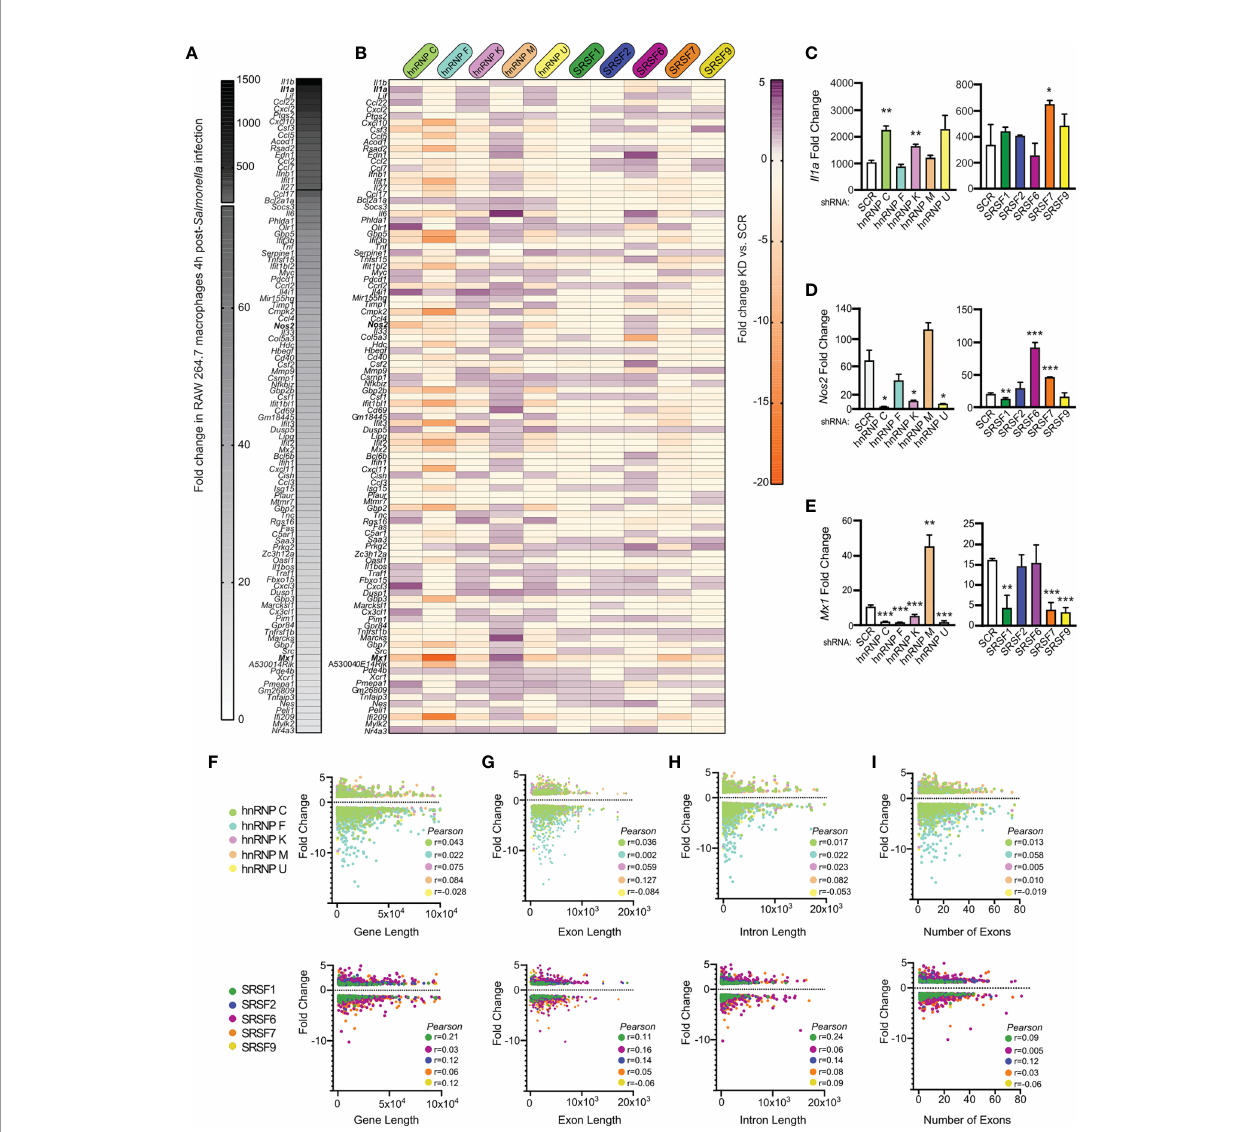
FIGURE 6 | Level of induction upon Salmonella infection, gene length, and number of introns/exons do not positively correlate with a gene ’ s reliance on SR/hnRNPs to maintain proper expression levels. (A) Heatmap of the top 100 genes induced at 4h post- Salmonella infection in SCR control RAW 264.7 macrophages. Data shown as fold change in SCR cells + Salmonella vs. SCR cells uninfected. (B) Heatmap of up- or down-regulation (fold change) of each induced gene conferred by hnRNP or SRSF knockdown. Purple genes are upregulated in SR/hnRNP knockdowns relative to SCR; Orange genes are downregulated in SR/hnRNP knockdowns. (C) RT- qPCR of Il1a abundance relative to Actb in Salmonella -infected SRSF and hnRNP knockdown macrophages (shown as fold change relative to uninfected for each cell line). (D) As in (C) but for Nos2 . (E) As in (C) but for Mx1 . (F) Scatter plot depicting correlation of the fold change of each DEG vs. coding sequence (CDS) length in Salmonella -infected hnRNP (top) and SRSF (bottom) knockdown macrophages. (G) as in (F) but comparison of DEG fold change vs. exon length. (H) As in (F) but comparison of DEG fold change vs. intron length. (I) As in (F) but comparison of DEG fold change vs. number of exons in a DEG. Genes included in analysis were differentially expressed (p < 0.05) in each knockdown compared to SCR controls. Y-axes were made all the same to facilitate comparison between multiple knockdown cell lines. For all RT-qPCRs values are the mean of 2 or 3 biological replicates and error bars indicate standard deviation. *p < 0.05; **p < 0.01; ***p <